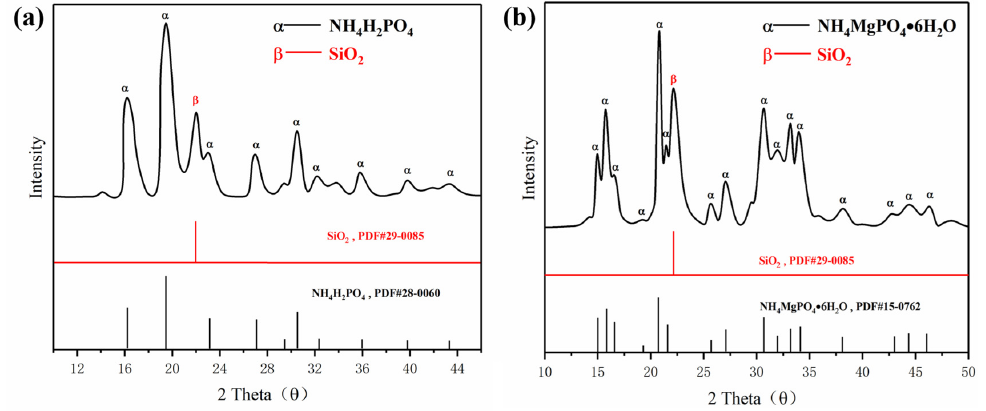
Figure 1. XRD analysis of ( a ) NH 4 H 2 PO 4 powder and ( b ) struvite.